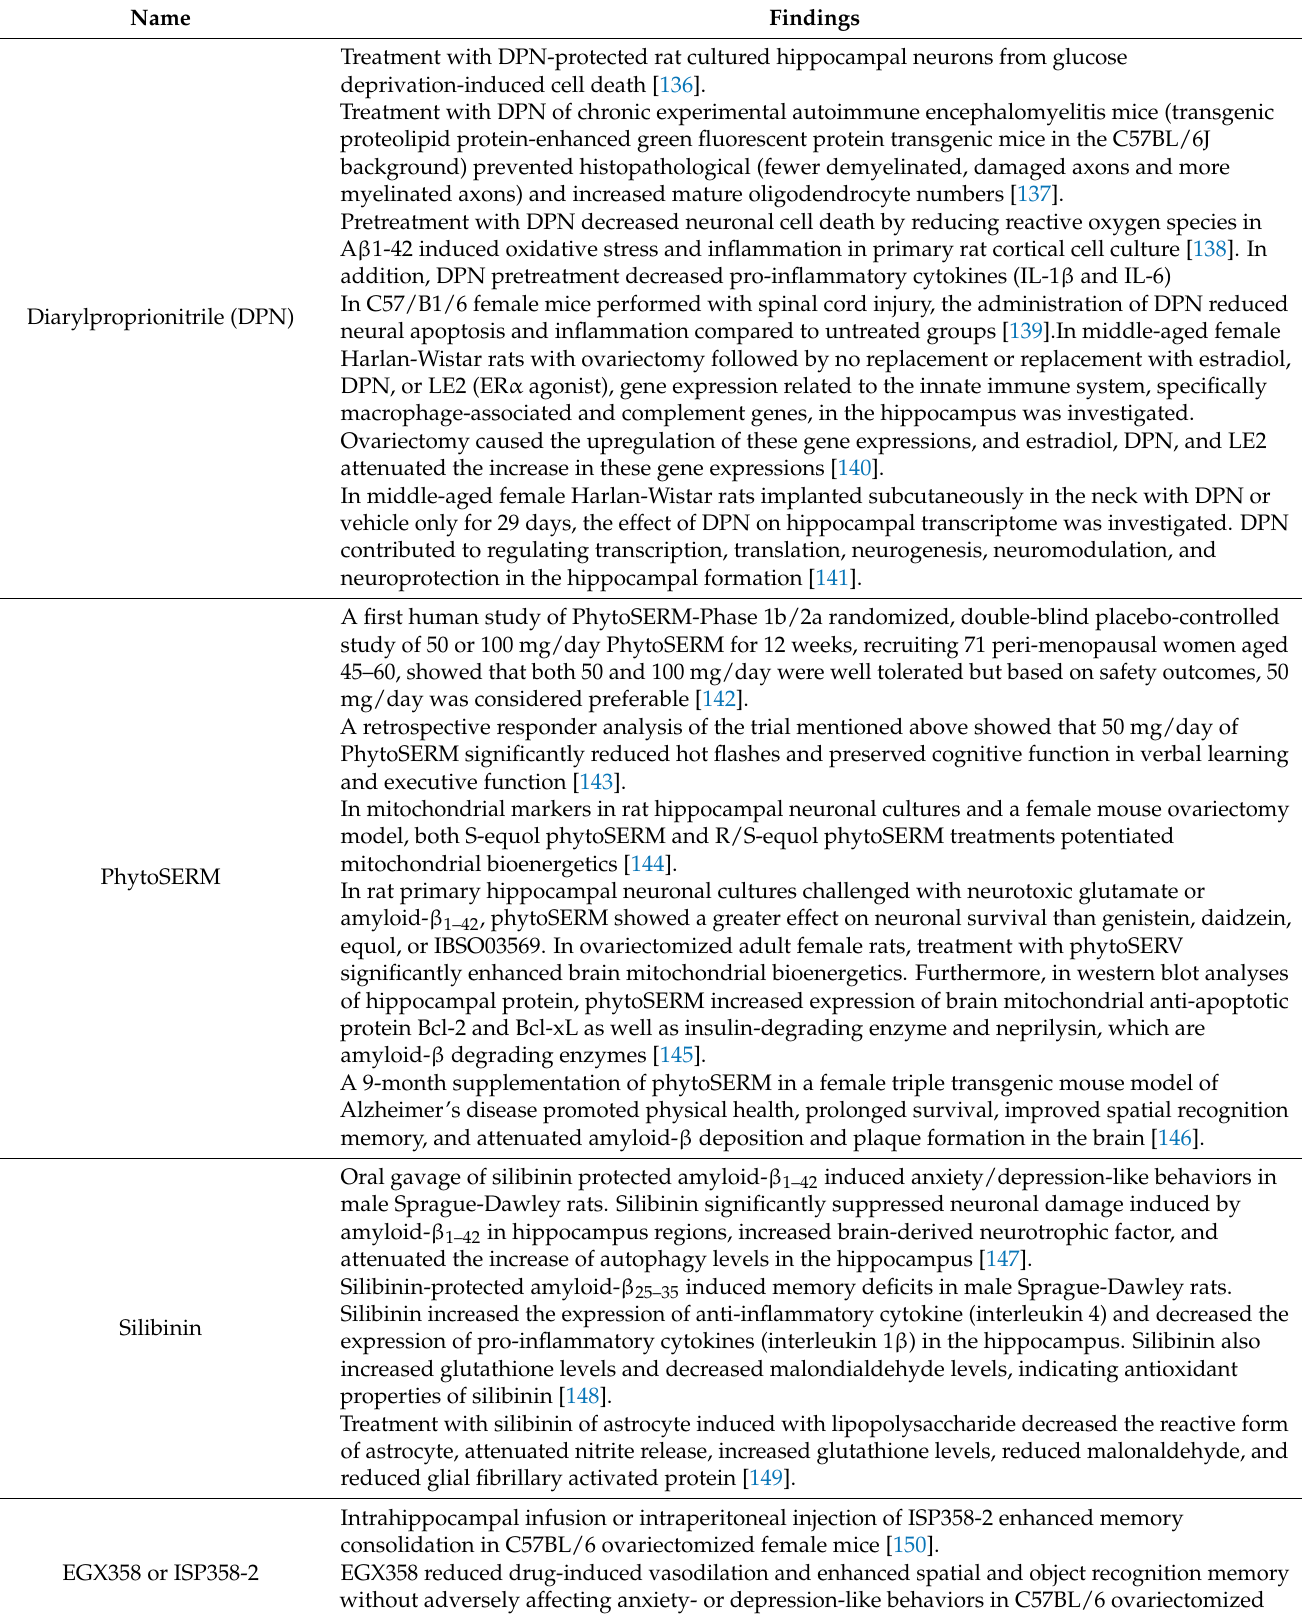
Table 2. Estrogen receptor β agonists are being investigated for